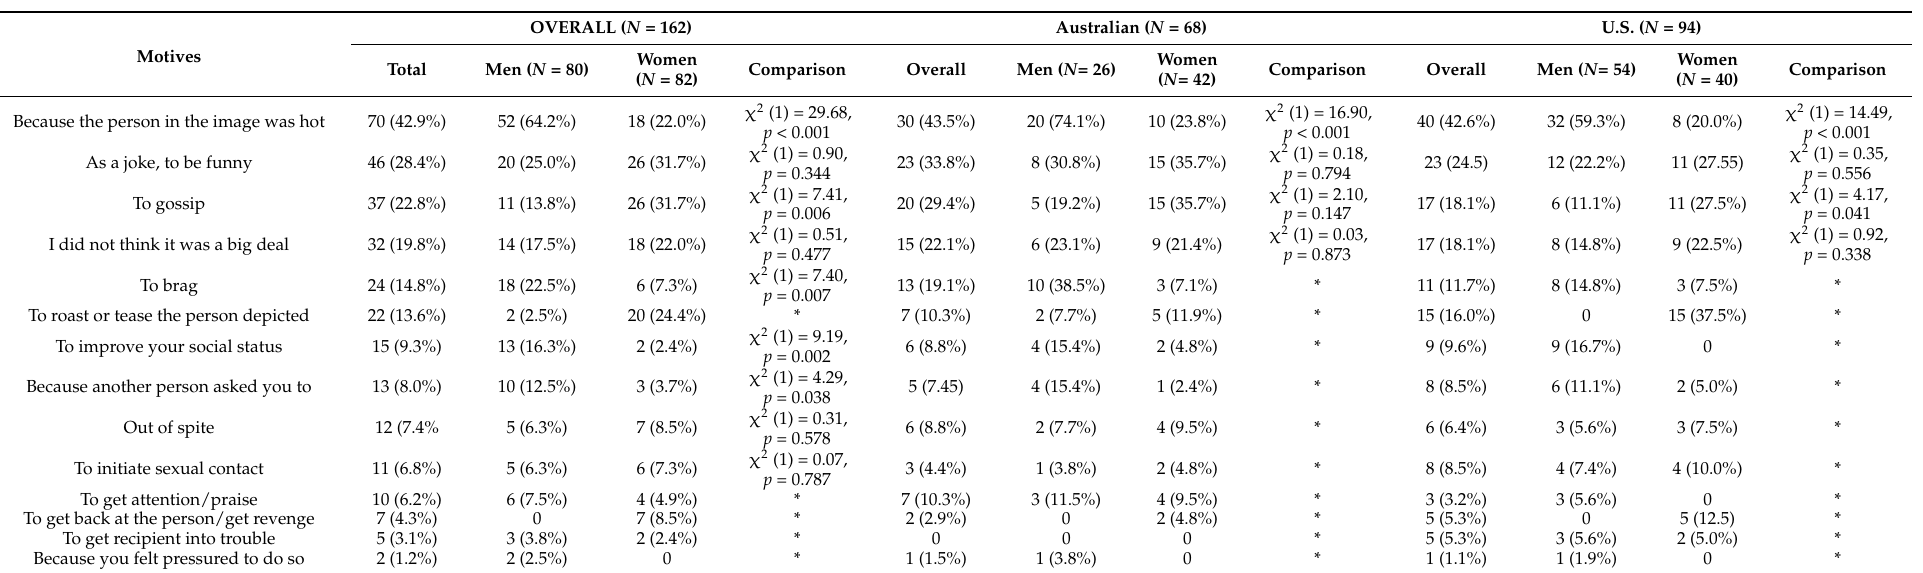
Table 4. Motivations for sext dissemination by country and